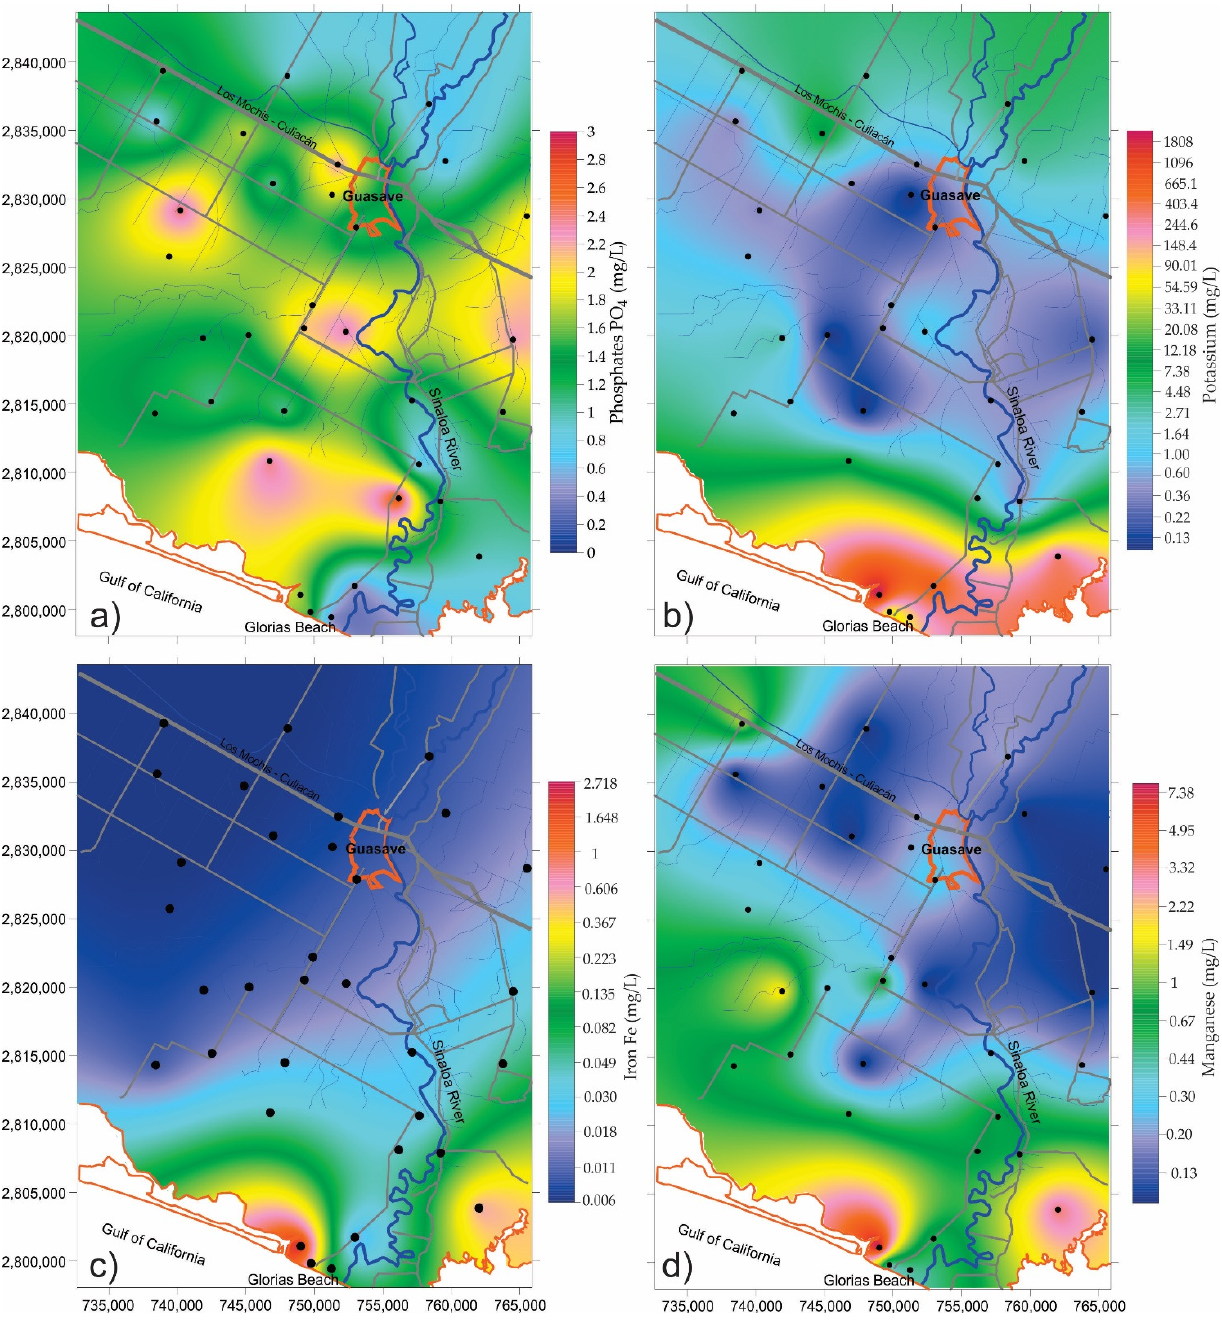
Figure 6. Behavior of the concentrations of ( a ) phosphate, ( b ) potassium, ( c ) iron and ( d ) manganese in the groundwater in the study area.